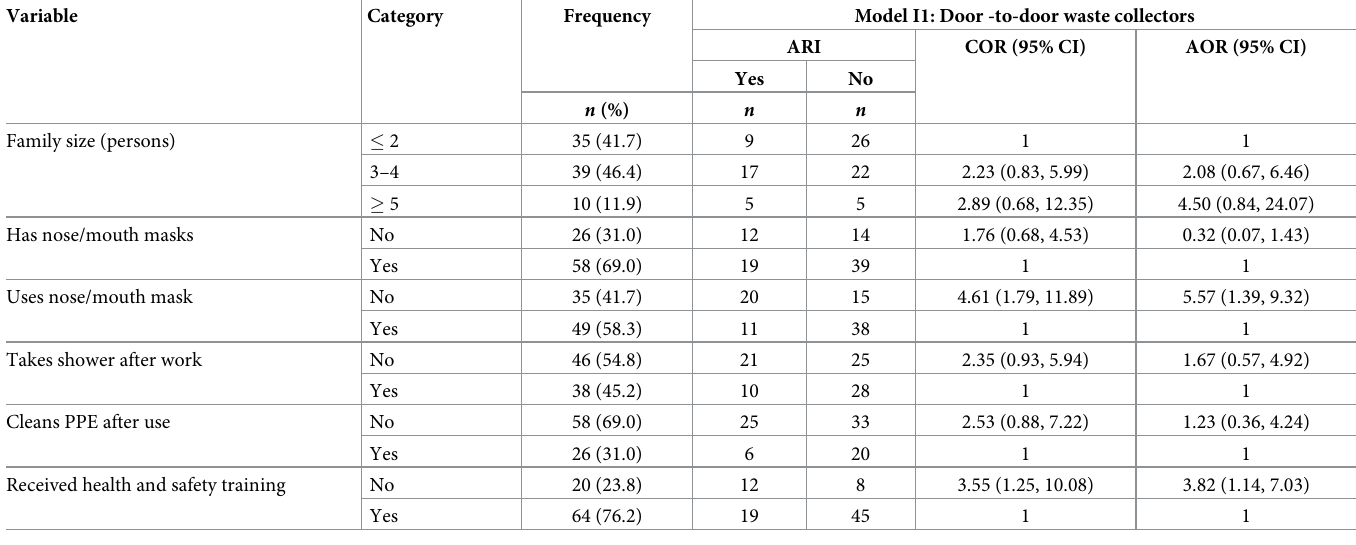
Table 7. Factors associated with ARI among door-to-door waste collectors from multivariable logistic regression analysis in Dessie City, Ethiopia, March to May 2018.